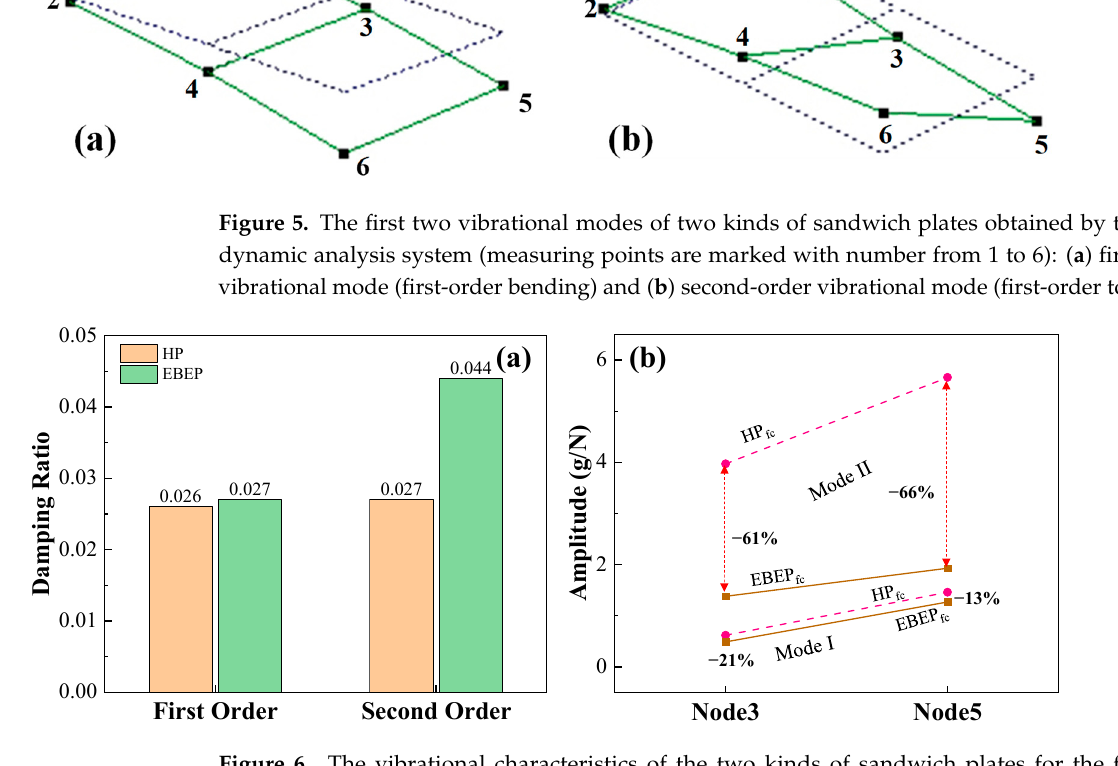
Figure 6. The vibrational characteristics of the two kinds of sandwich plates for the first two vibra- tional modes: ( a ) damping ratio and ( b ) the first two vibrational amplitude responses of different nodes.